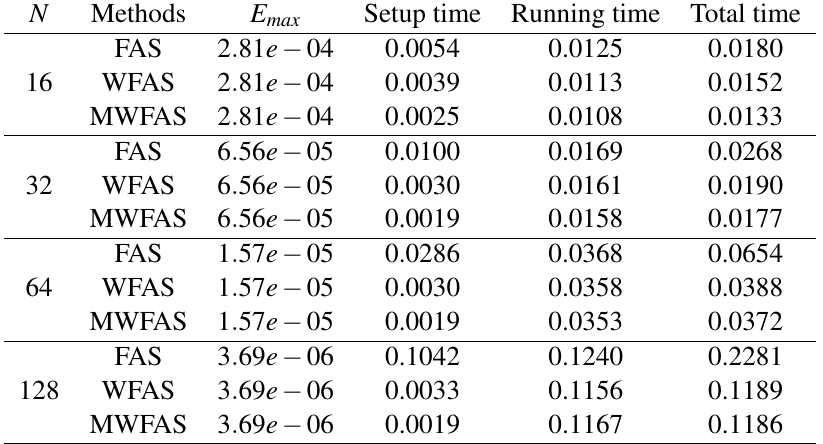
Table 10 Maximum error and CPU time (in seconds) of the methods of test problem 5.5.